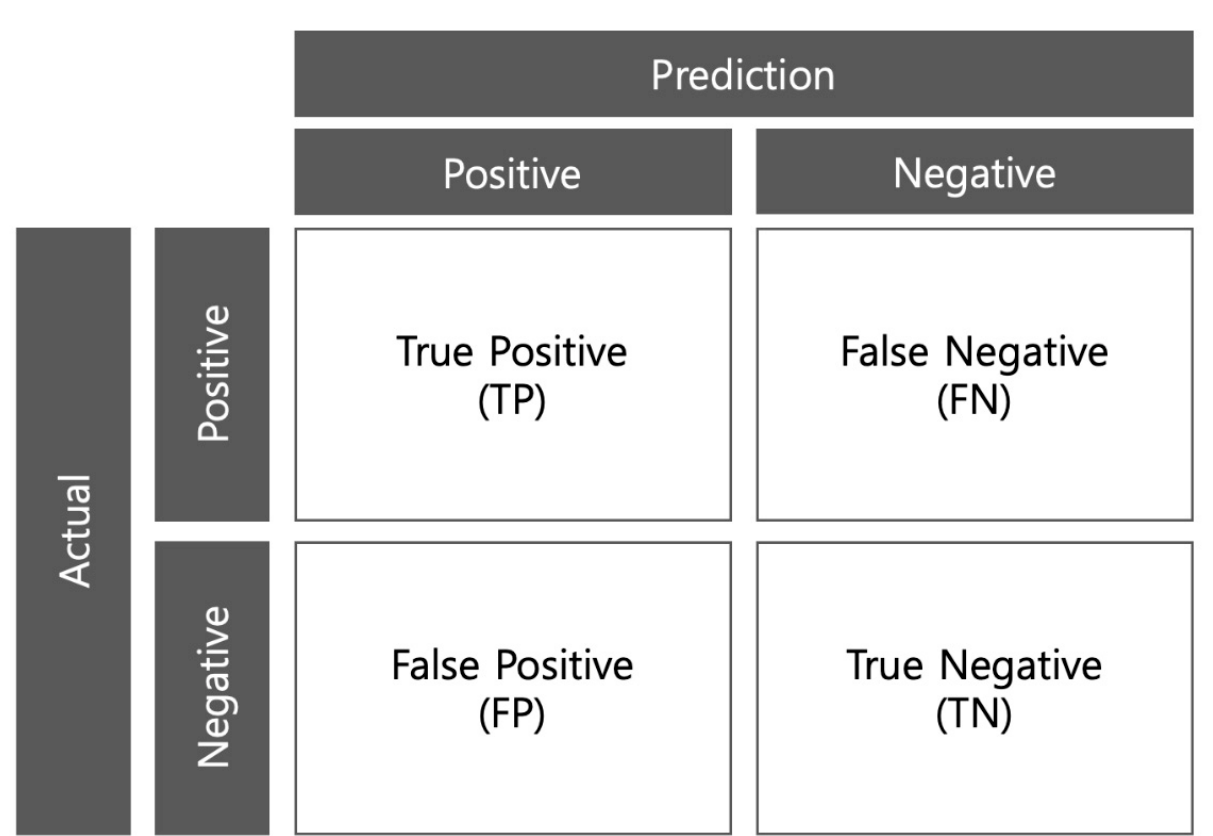
Figure 4. Four factors to obtain the mean average precision index.